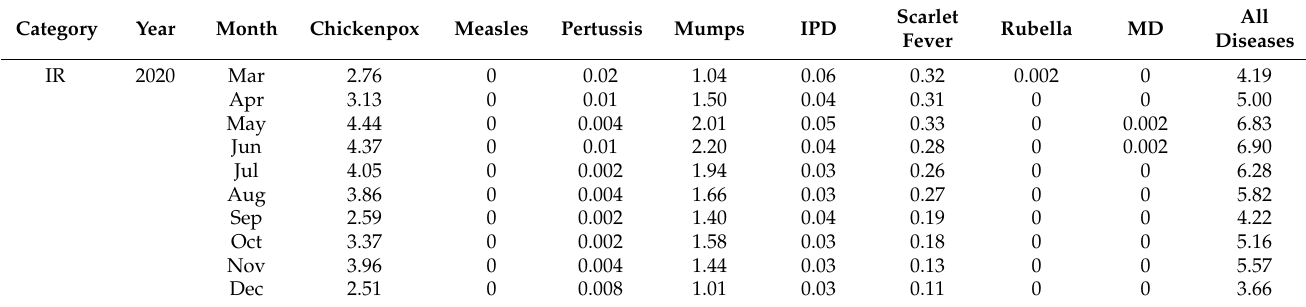
Table A2. Monthly IRs and AS-IRs of eight infectious respiratory diseases in intervention and pre-intervention periods.